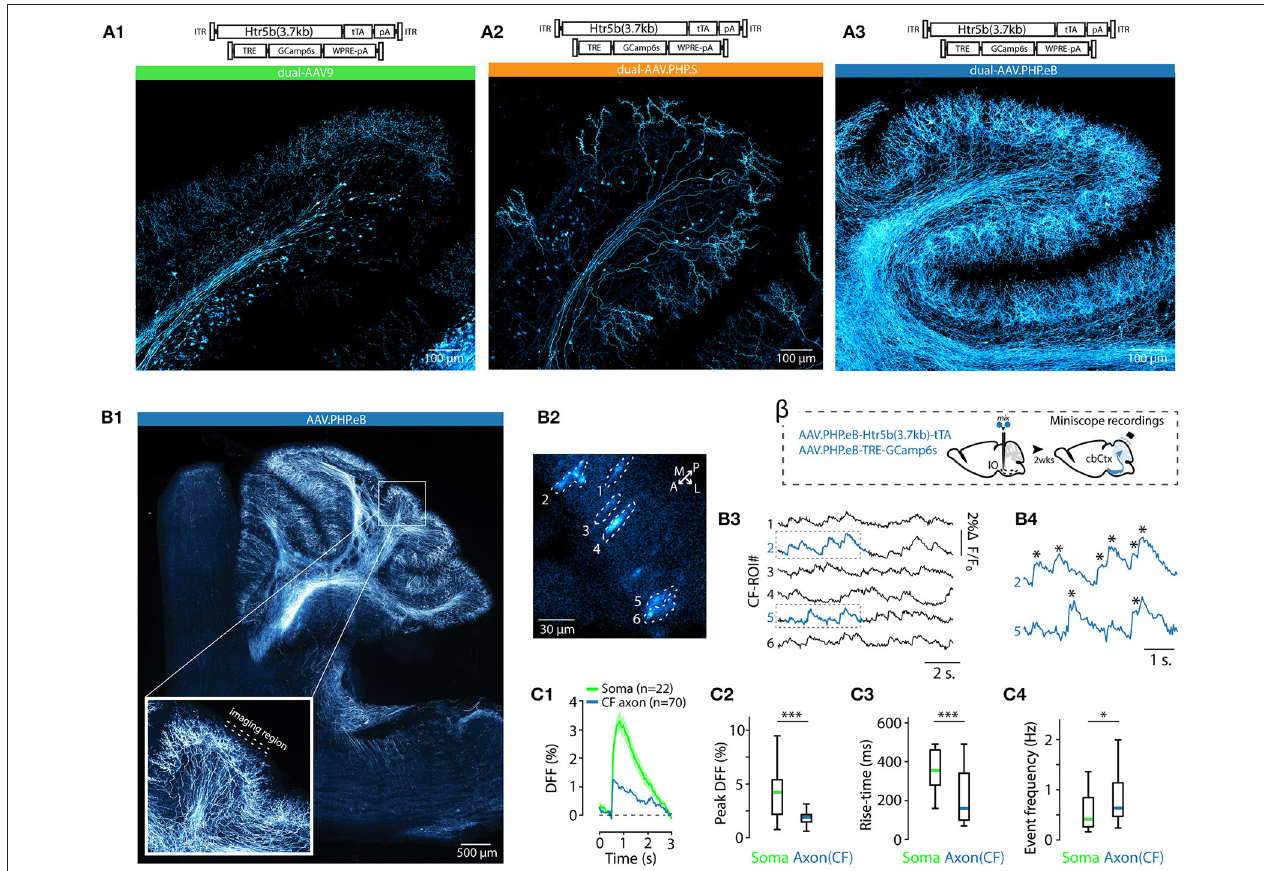
FIGURE 12 | Recording of climbing fiber calcium events in vivo. (A1–A3) Expression of GCaMP6s in cerebellar climbing fibers with AAV9, AAV.PHP.S, AAV.PHP.eB-Htr5b(3.7)-tTA/TRE constructs, respectively. (A1-A3) are tiled and Z-projected 40x confocal images of sagittal cerebellar sections showing expression of GCaMP6s in axons in the cerebellar cortex with samples prepared for anatomical study. Expression of GCaMP6s in CF is sparse in when the viral serotype is AAV.PHP.S, while dense and widespread with AAV.PHP.eB serotype. The inset [in (B1) ] indicates the region that was imaged in with the miniscope (see schematic on top of the figure). (B) Example recording from CFs in a living mouse. (B1) Is a sagittal slice from tissue on the same brain where in-vivo calcium imaging was done. A schematic labeled beta describes the experiment procedure. (B2) , z -projection image (standard deviation) of miniscope calcium recording time series (20 second recordings per zone) as seen from the dorsal surface of the cerebellar cortex. Anterio-posterior (AP) and medio-lateral (ML) directions are indicated with white arrows. The dashed lines indicate manually-drawn ROIs for CFs, and the respective calcium traces are shown in (B3) . Parts of two of the traces [2 and 5, indicated by dashed rectangles in (B4) ] are shown with expanded time scale at the bottom of the panel. Detected events are indicated by asterisks. (C) Comparing in vivo calcium events recorded in IO axons (CFs; blue) with the somata (green). n = 70 events in 2 animals for axon recordings, 22 events in 4 animals for somata. (C1) Average in-vivo GCaMP6s transients from CFs and IO somata, aligned at initiation point. Shaded regions represent ± SEM. (C2) Comparison of calcium event amplitudes in IO somas and axons when normalized to basal fluorescence (1-way ANOVA, f = 8.19, p < 0.001). (C3) Comparison of event rise-times between IO soma and climbing fibers (1-way ANOVA, f = 5.3, p < 0.001). (C4) Comparison of the instantaneous frequency of events (inverse of inter-event interval) in the axon vs. the soma (1-way ANOVA, f = 5.35, p < 0.023). Note the slower spike rate in somatic recordings, possibly due to tissue cooling during the ventral surgery needed for somatic